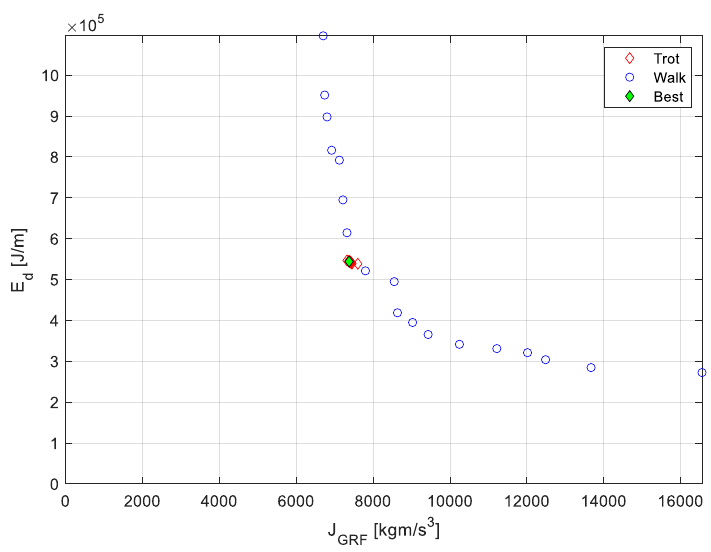
Figure 8. Pareto curve of optimal gaits for 𝑉 = 1.35 𝑚/𝑠 and 𝑇 = 1 𝑠 .